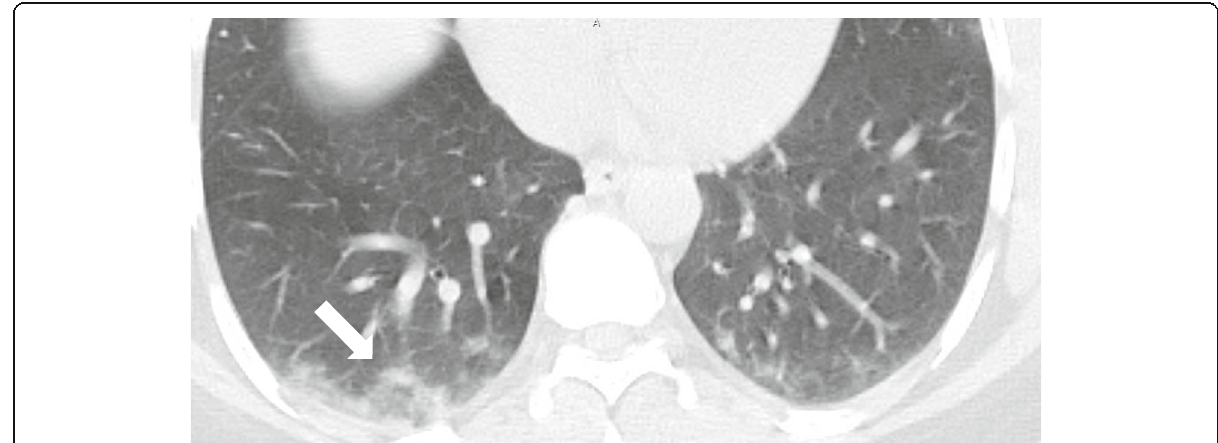
Fig. 16 A 37-year-old female patient with COVID-19 with 4 days of fever cough and dyspnea, CT chest axial image shows predominantly subpleural ground glass opacities with vascular thickening and shows a right lower lobe subpleural opacity with “ reversed halo ” sign